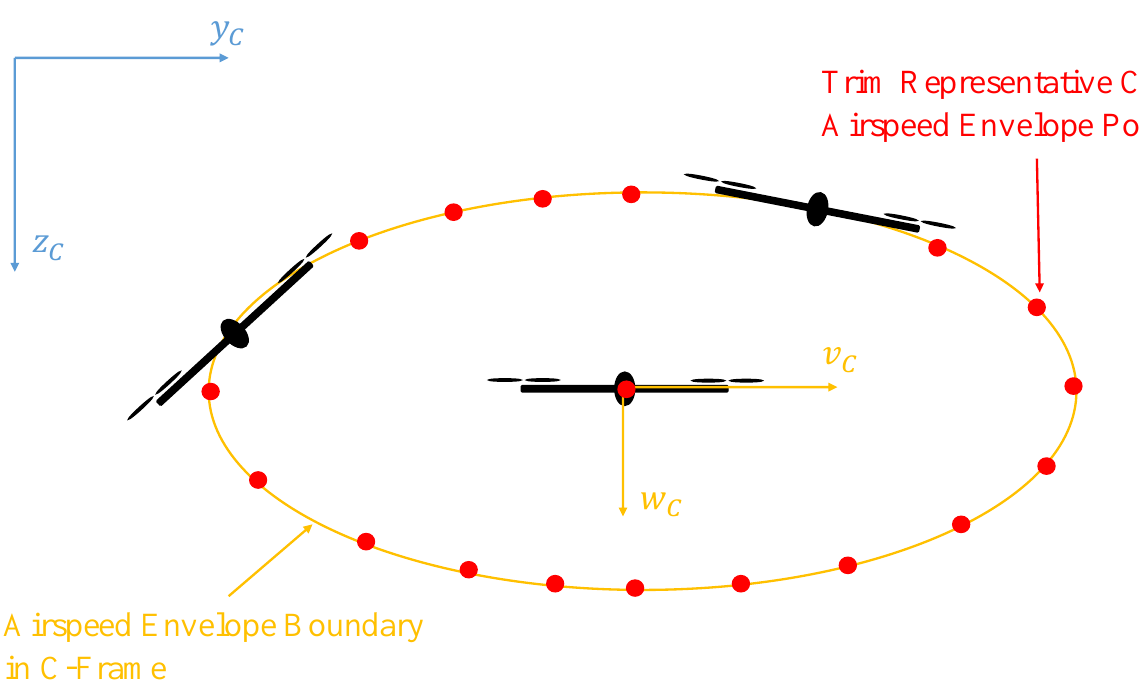
Figure 3. Exemplary distribution of boundary points on the aerodynamic velocity envelope in the control frame (2D example for visualization